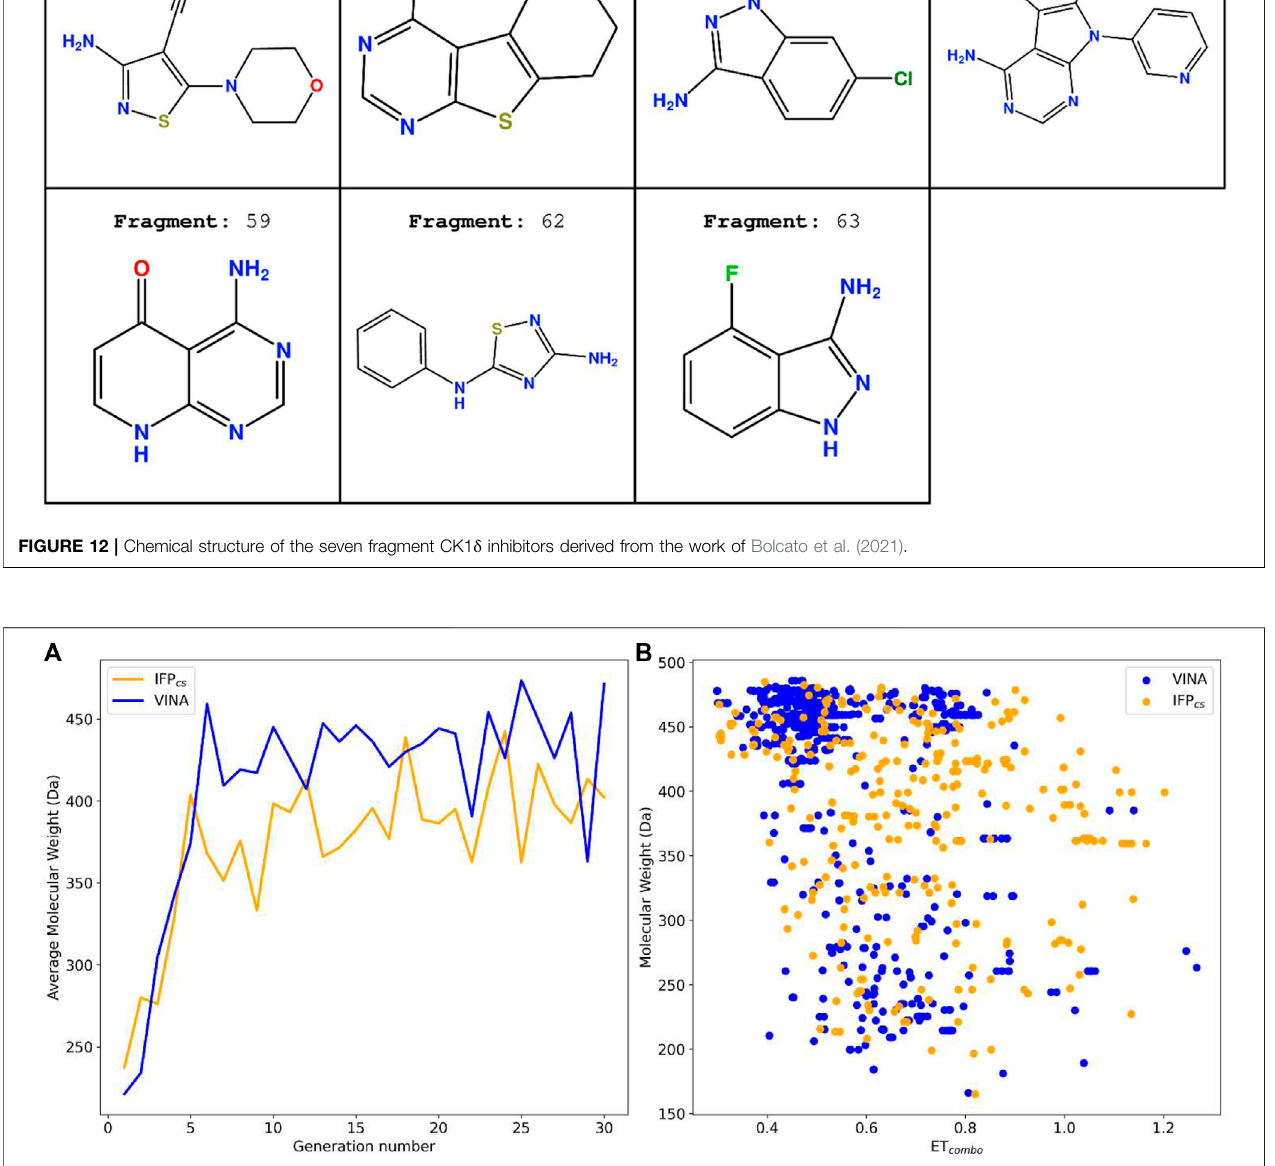
FIGURE 13 | Performance of the two Autogrow protocols in the prospective de novo runs regarding their ability to generate compounds that pass the pharmacophore fi lter. The VINA protocol is reported as a blue line, while the IFP CS one is reported as an orange line. Panel (A) depicts, for each protocol, the average molecularweight ofcompounds within thepopulation thatpassthe pharmacophore fi lteron aper-generation basis.The vertical axis reports the molecular weight,while thehorizontalaxisreportsthegenerationnumber.Panel (B) depicts,foreachprotocol,thedistributionofgeneratedcompoundsthatpassthepharmacophore fi lter regarding their molecular weight and the similarity of shape and electrostatic properties to crystal inhibitors taken as reference. The vertical axis reports the average molecular weight in Da, while the horizontal axis reports the ET combo value. The blue dots represent compounds generated by the VINA protocol, while the orange dots represent compounds generated by the IFP CS